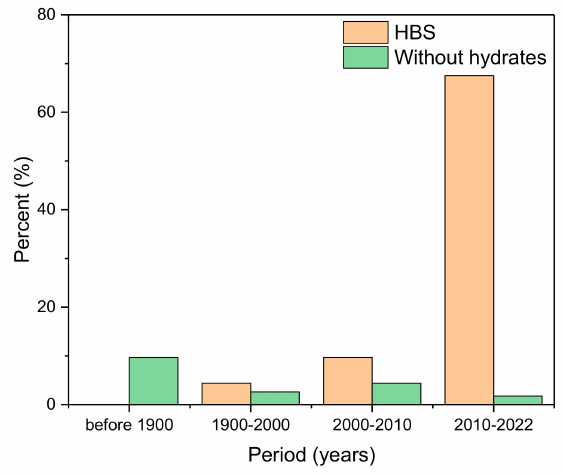
Figure 12. Research-trend of HBS and without hydrates on seepage in past few decades.